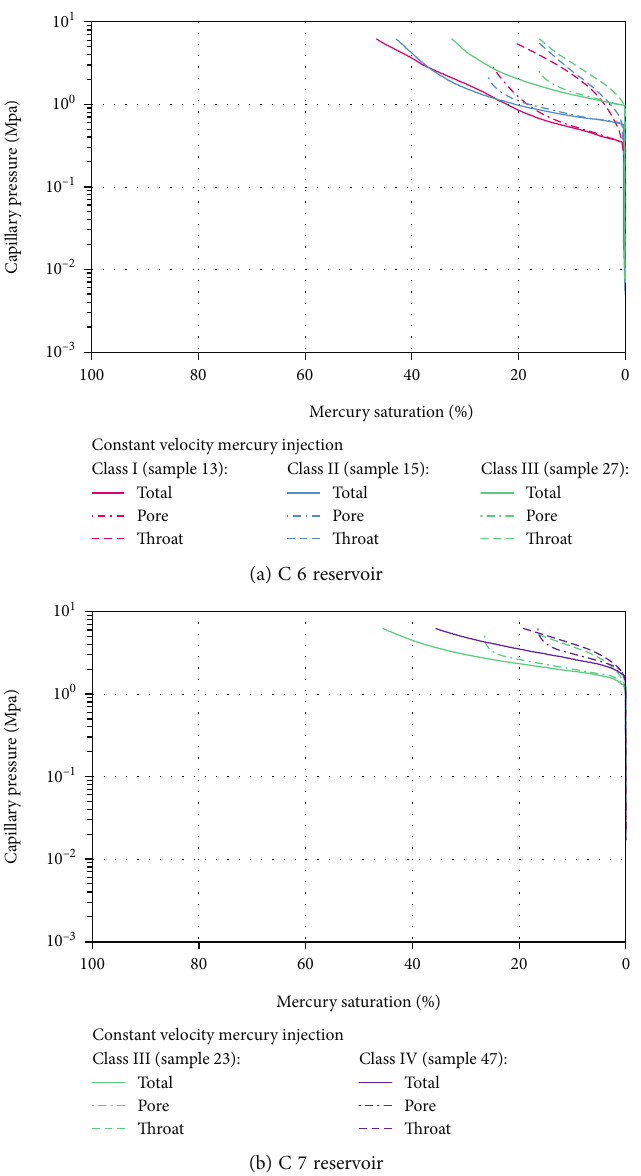
Figure 8: The capillary pressure curve of constant-speed mercury penetration